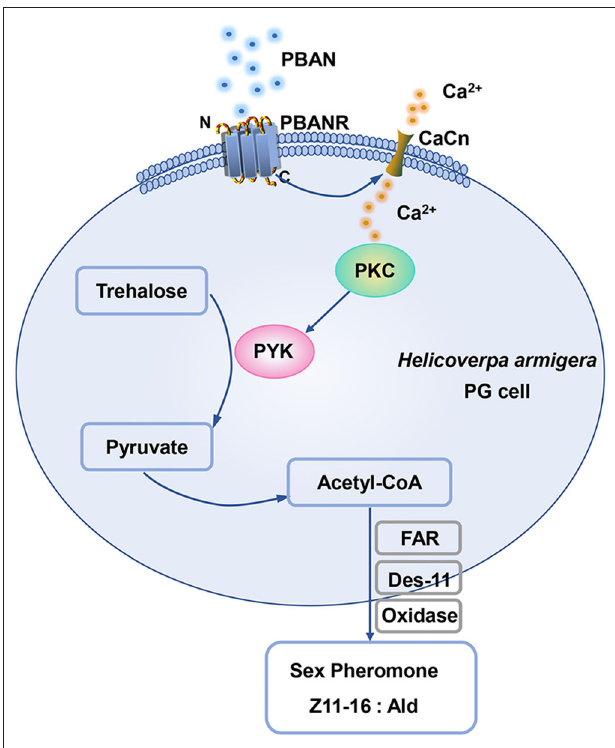
FIGURE 6 | The diagram of HaPYK in the PBAN-induced sex pheromone